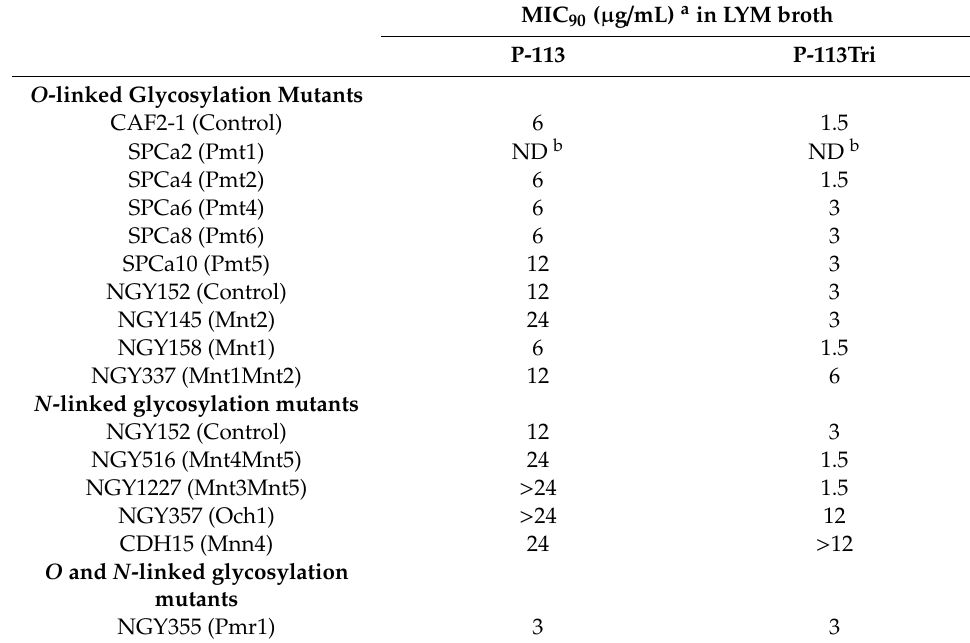
Table 2. The minimum inhibitory concentrations (MICs) of P-113 and P-113Tri against C. albicans glycosylation